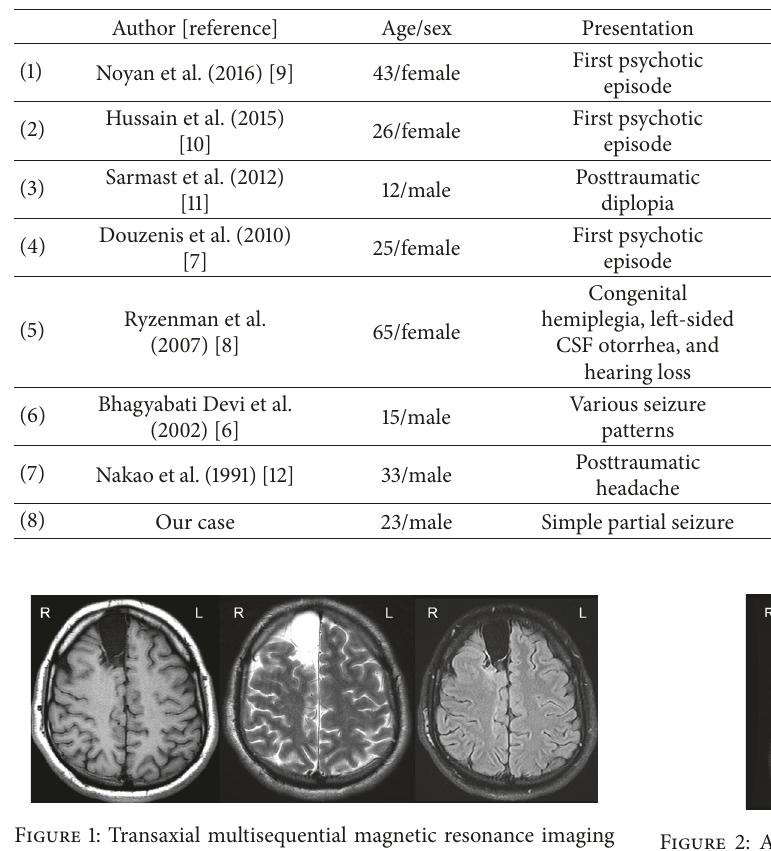
Table 1: Summary of previously reported cases of acquired porencephaly.